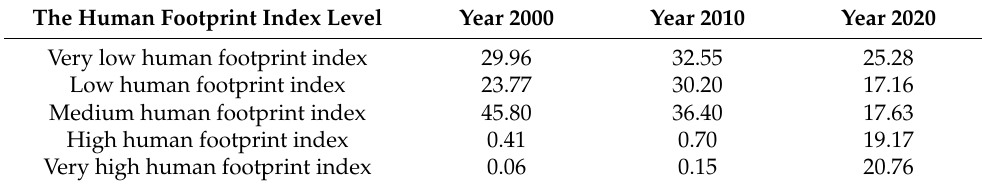
Table 7. Distribution ratio table of human footprint index grades in 2000, 2010, and